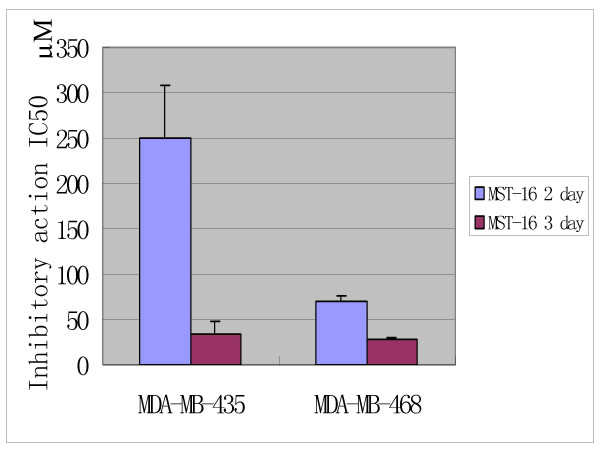
Differences of anticancer effects (IC50) of MST-16 for different exposure intervals by a MTT method, n = 3 for 2 independent tests.